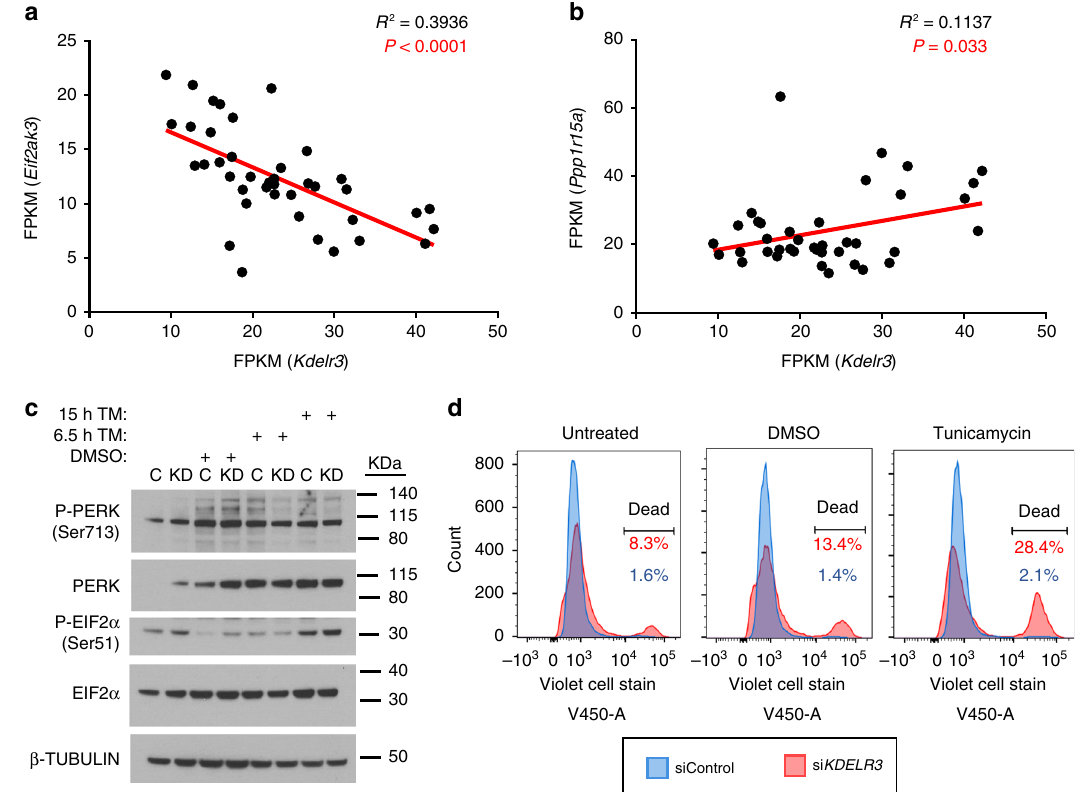
Fig. 4 KDELR3 and the ER stress response in metastatic melanoma. a Scatter plot of Eif2ak3 ( Perk ) RNA expression vs. Kdelr3 RNA expression. Linear regression analysis, R 2 = 0.3936, P < 0.0001. b Scatter plot of Ppp1r15a ( Gadd34 ) RNA expression vs. Kdelr3 RNA expression. Linear regression analysis, R 2 = 0.1137, P = 0.03. a , b Data from four independent mouse models of melanoma (see Methods). Each dot represents one mouse. M1, N = 9 mice; M2, N = 6 mice; M3, N = 12 mice; M4, N = 13 mice. c Western blot analysis of PERK and eIF2 α signaling (1205Lu cells). Non-targeting control (shControl, C) and KDELR3 knockdown (sh KDELR3 , KD) in cells were untreated or treated with 3 µ g/ml tunicamycin (TM) or DMSO control for the indicated time. Immunoblot with antibodies speci fi ed, β -tubulin loading control. d Live/dead violet cell stain in KDELR3 -knockdown 1205Lu cells. Untreated, DMSO, and tunicamycin (2.5 μ g/ml) treatment groups were treated 18 h before collection. The right-hand peak on the graph indicates the percentage of dead cells. Representative of three independent experiments ( c , d